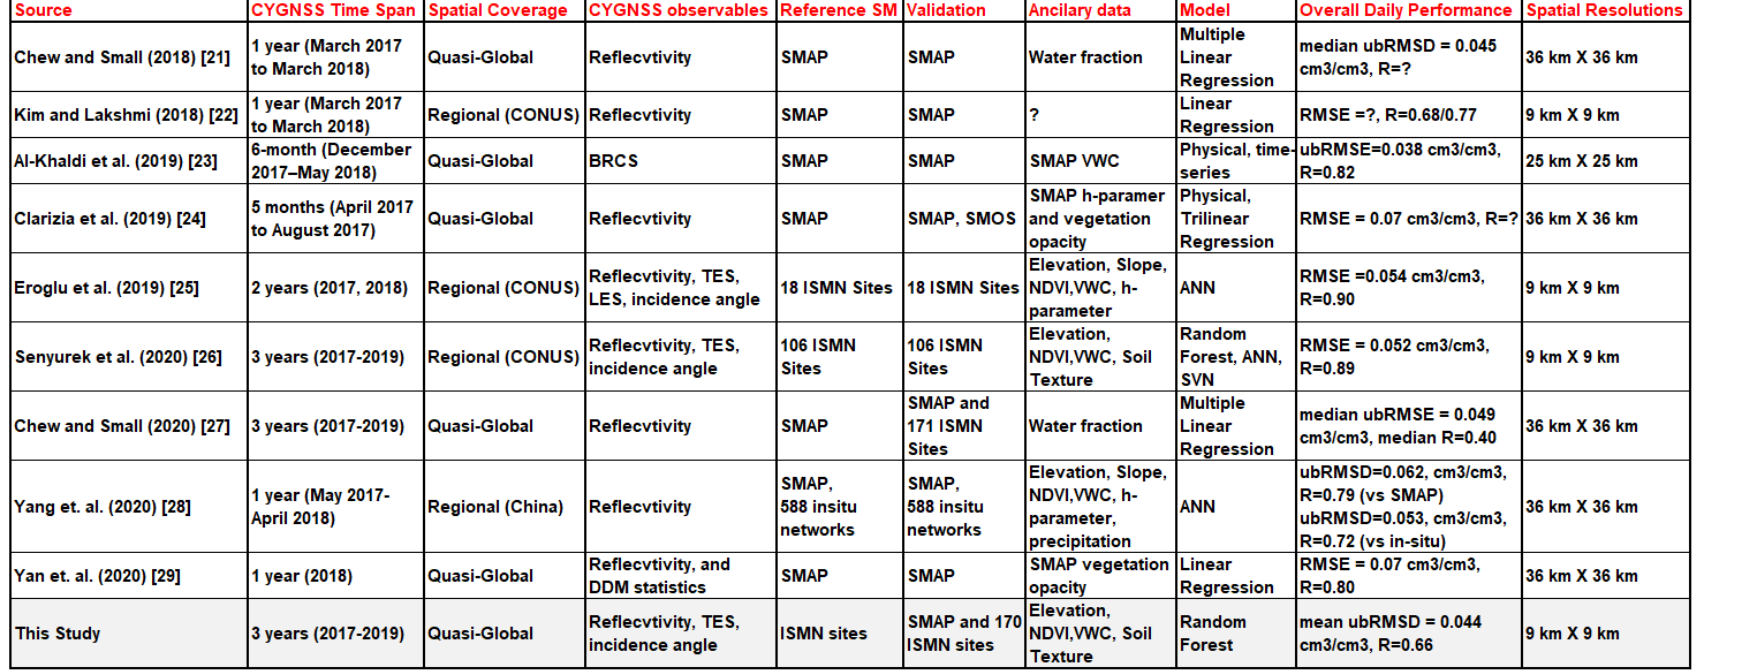
Figure A1. A list of recent CYGNSS-based SM retrieval approaches that mostly differ in (1) assumptions regarding gridding, open water masking, and surface conditions, (2) ancillary data requirements, (3) validation and reference data sets, (4) time spans, (5) models and (6) spatial coverage. The list is given in chronological